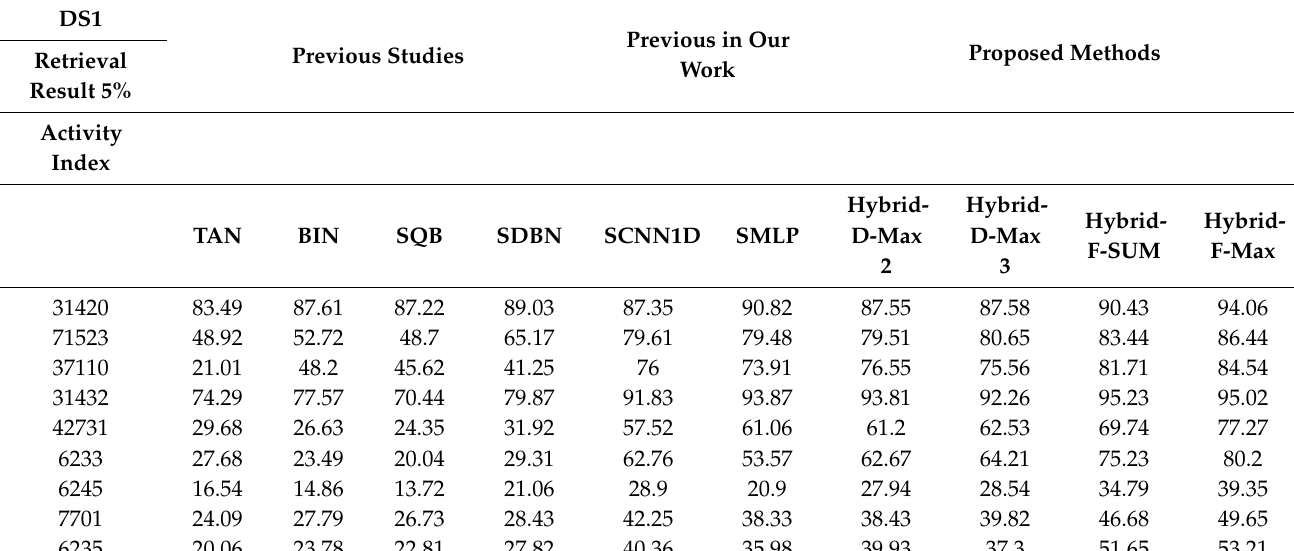
Table 6. Top 5% retrieval recall for MDDR-DS1 (structurally homogeneous and heterogeneous) dataset for descriptor (ECFC 4).